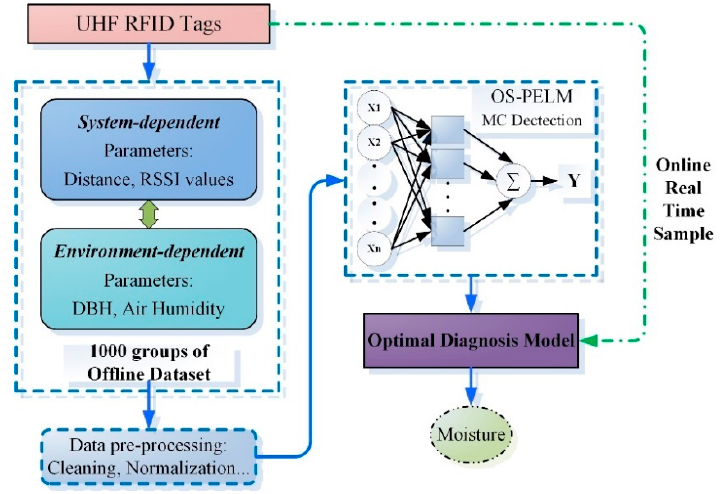
Figure 7. Framework diagram of the MC prediction model.